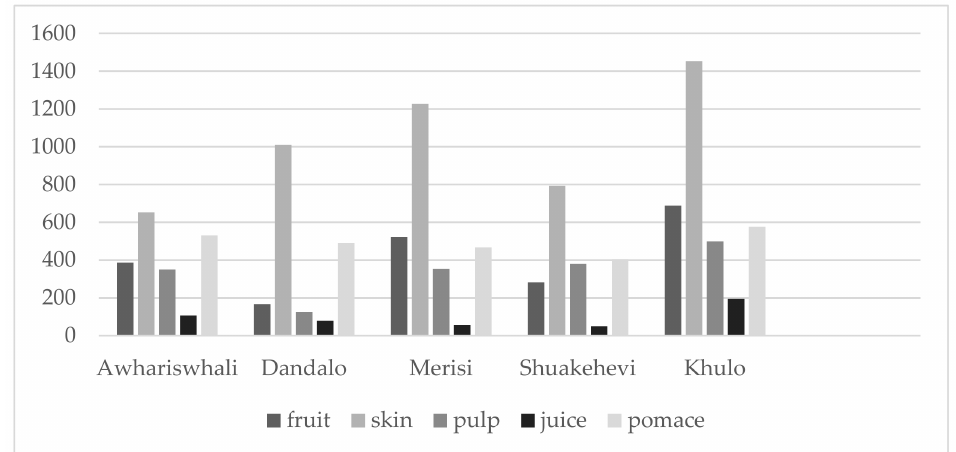
Figure 3. Catechin content (mg/kg) of different parts of the fruits collected from five villages, with catechins dominating the flavonoids and present especially in the skin and notably absent in the